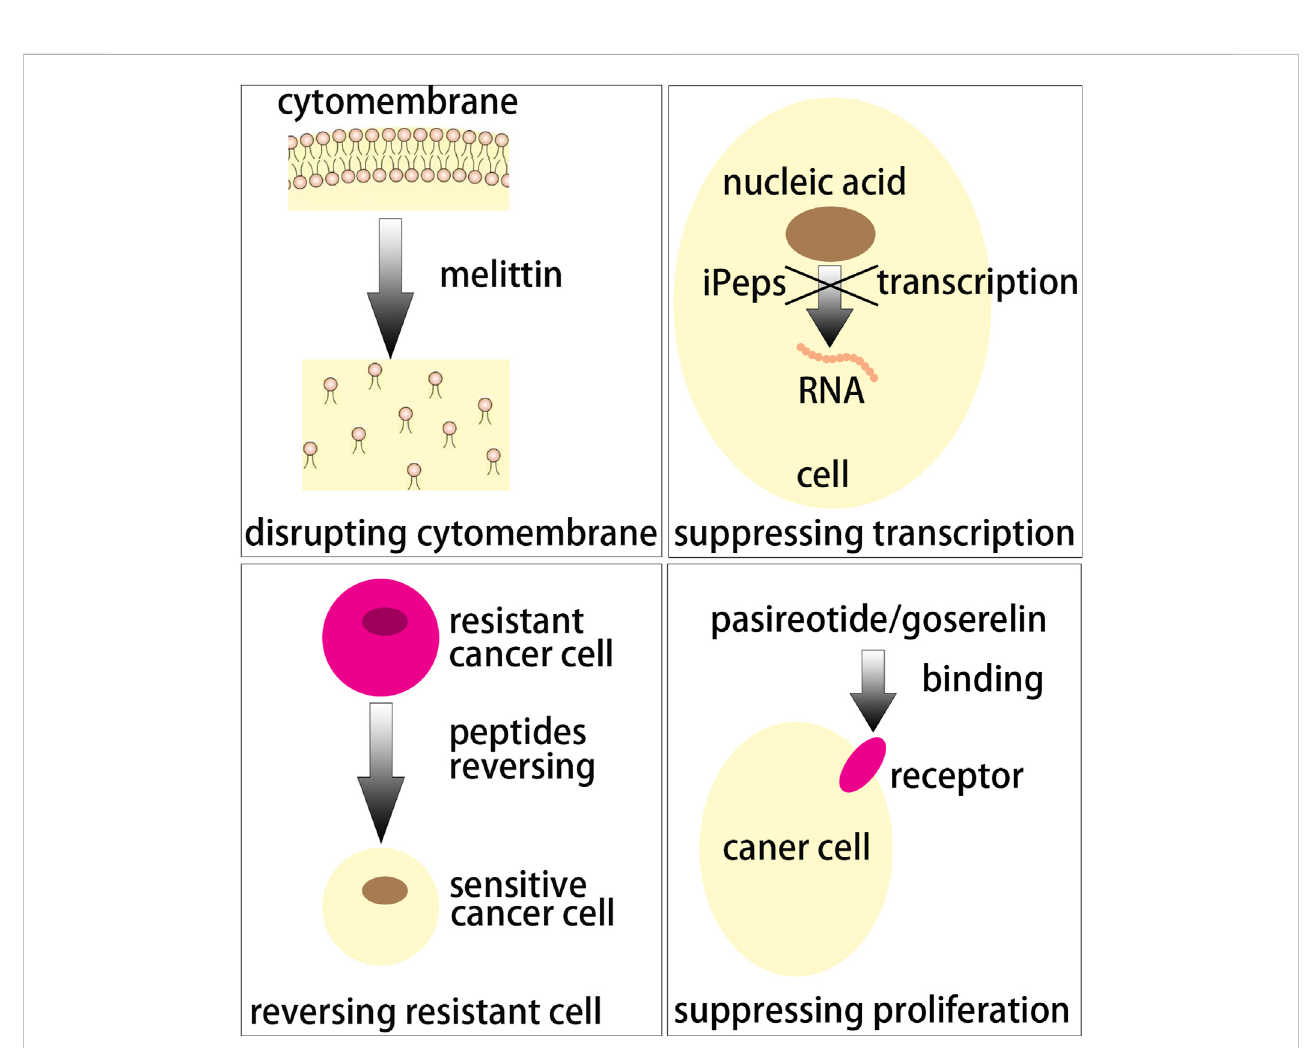
FIGURE 5 Several action mechanisms of peptide-based anticancer